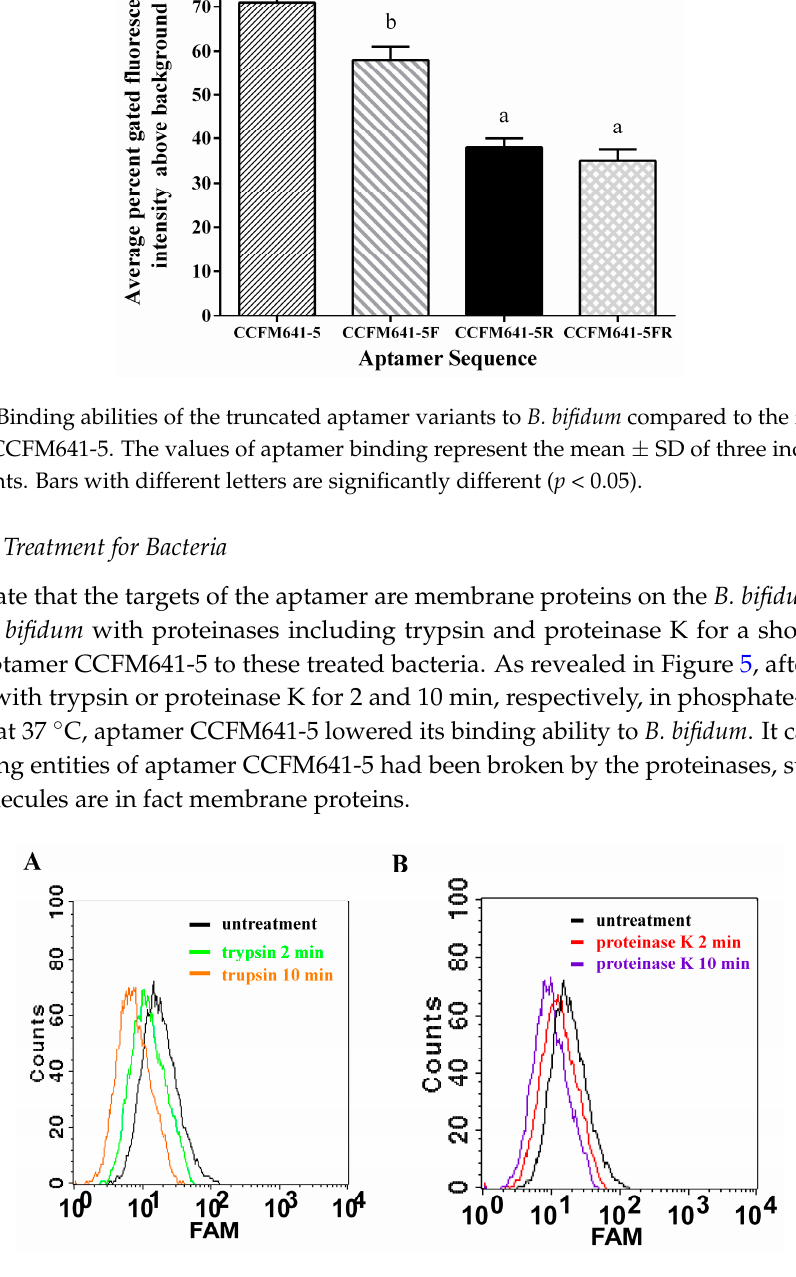
Figure 5. Binding assays of aptamer CCFM641-5 to trypsin-treated or proteinase K-treated B. bifidum . ( A ) Flow cytometric analysis of aptamer CCFM641-5 binding affinity for trypsin-treated B. bifidum ; ( B ) Flow cytometric analysis of aptamer CCFM641-5 binding ability to proteinase K-treated B. bifidum .